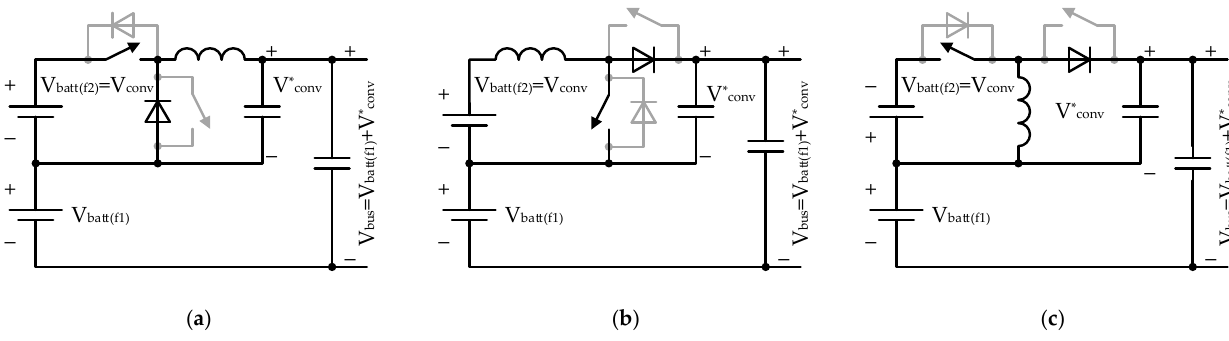
Figure 23. Partial power converters ( a ) vs. fractional power converters: ( b ) isolated, ( c ) non-isolated.